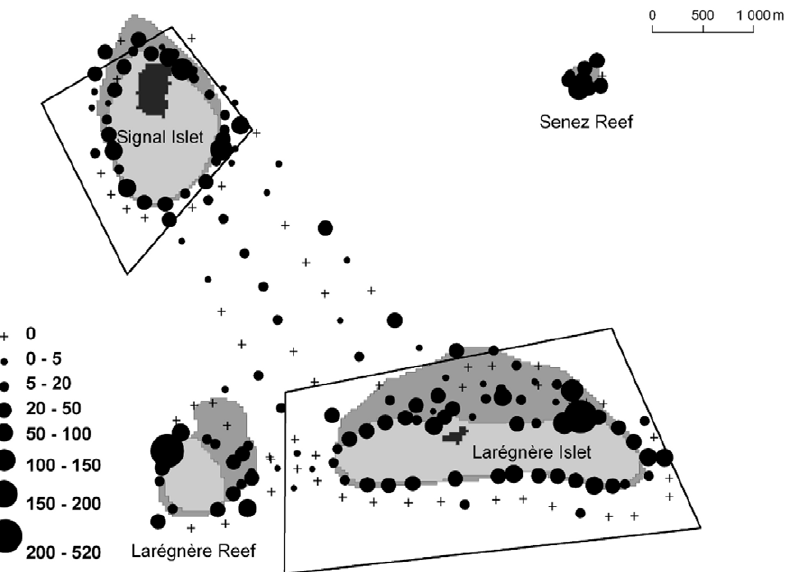
Figure 6. Maximum overall abundance per station. Circles are proportional to the maximum observed abundance density per station (i.e. MaxN) (see legend in insert, densities were plotted in # ind/100 m 2 ).